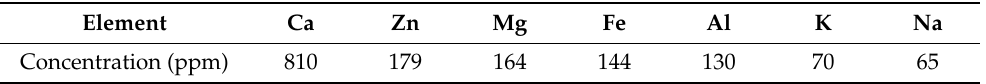
Table 1. Typical concentrations of trace elements contained in the black hair of Japanese adults [25].